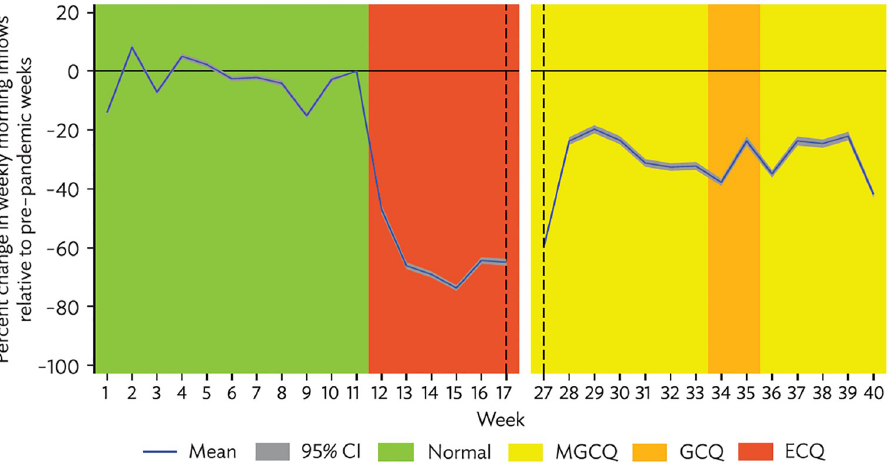
Fig 3. National mobility response to imposition of enhanced community quarantine. CI = confidence interval; ECQ = enhanced community quarantine; GCQ = general community quarantine; MECQ = modified enhanced community quarantine; MGCQ = modified general community quarantine. Note: Shading reflects the weekly most common form of community quarantine (at the origin level). Source: Authors’ calculations.